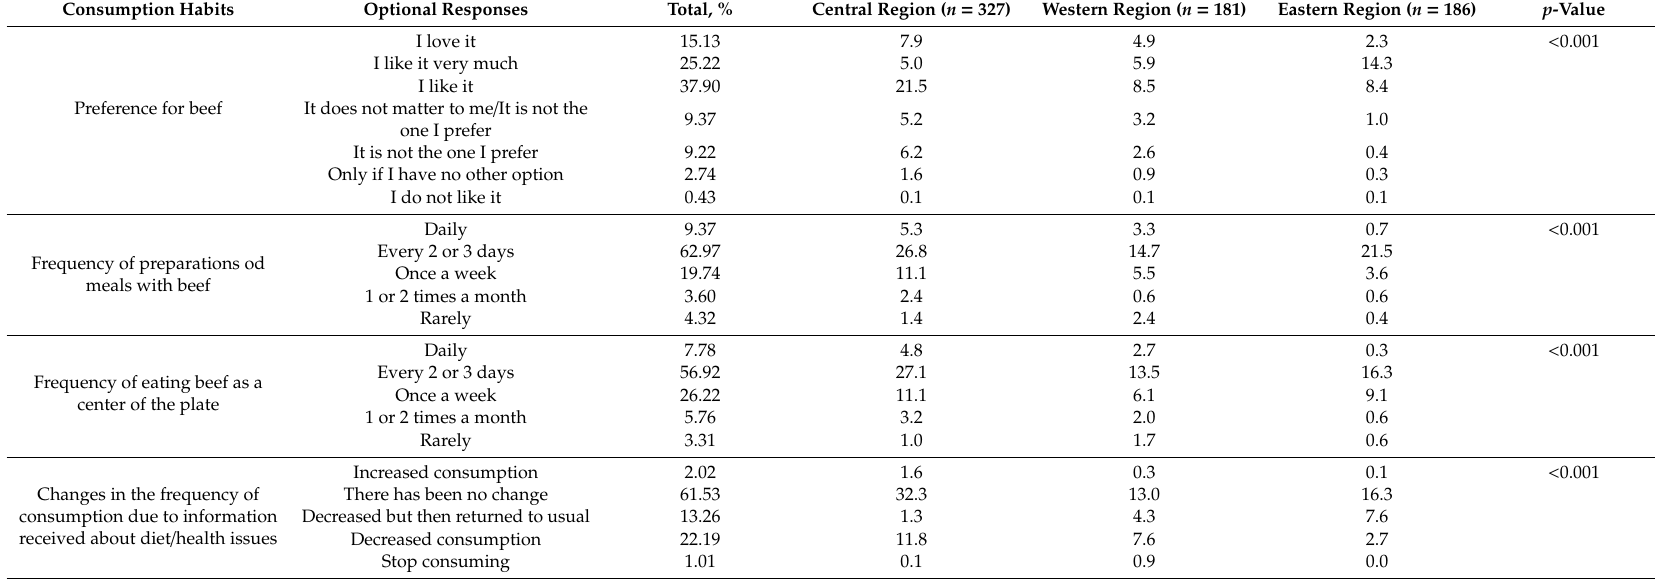
Table 2. Beef consumption habits for the whole sample and by